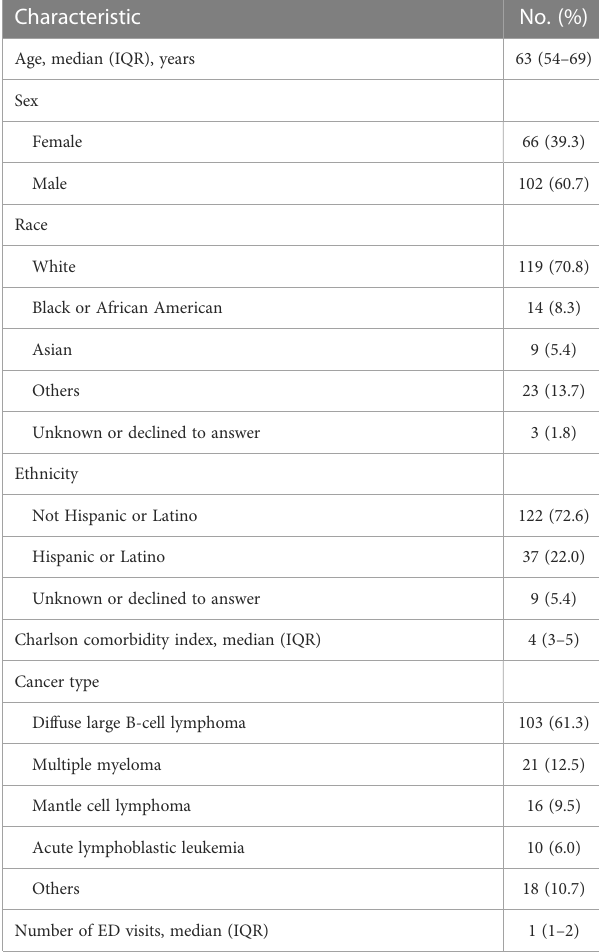
TABLE 1 Clinical and demographic characteristics of patients presenting to the emergency department (ED) after chimeric antigen receptor T-cell infusion therapy (n =